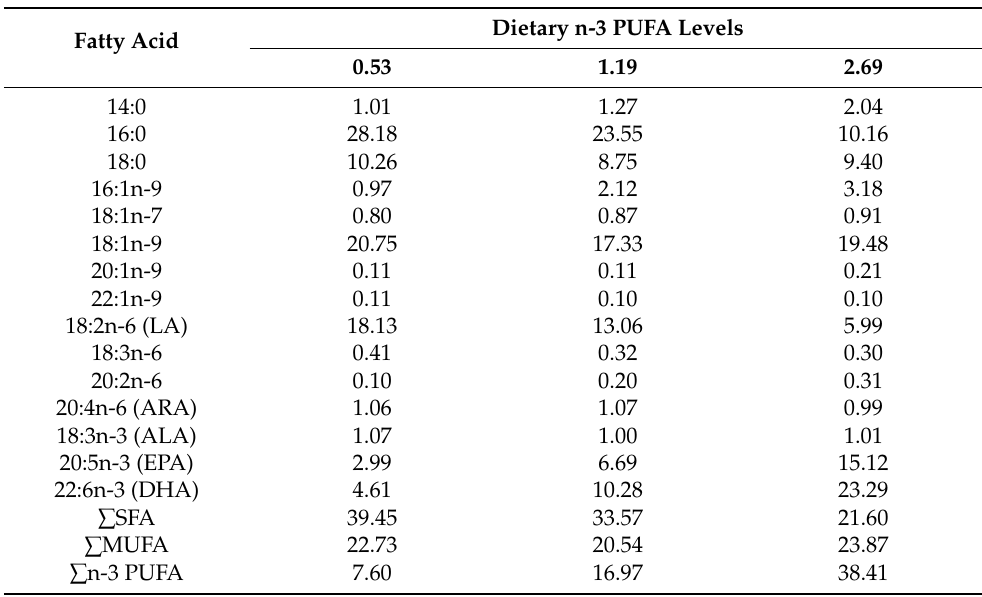
Table 3. Fatty acid composition of experimental diets. The results are expressed as the average of repeated samples; SFA: saturated fatty acid; MUFA: monounsaturated fatty acid; PUFA: highly unsaturated fatty